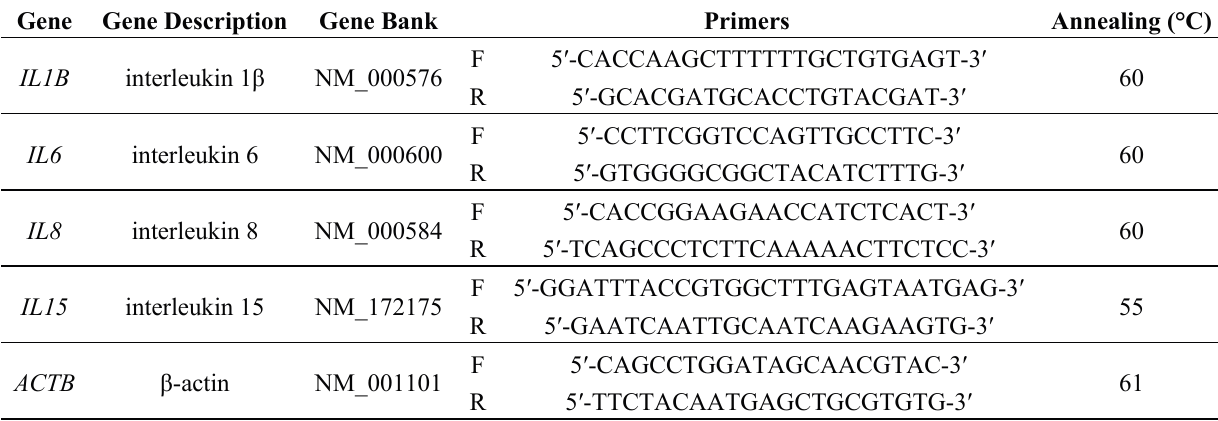
Table 2. Primers used for the analysis of cytokine expression on mRNA level in adipose tissues.